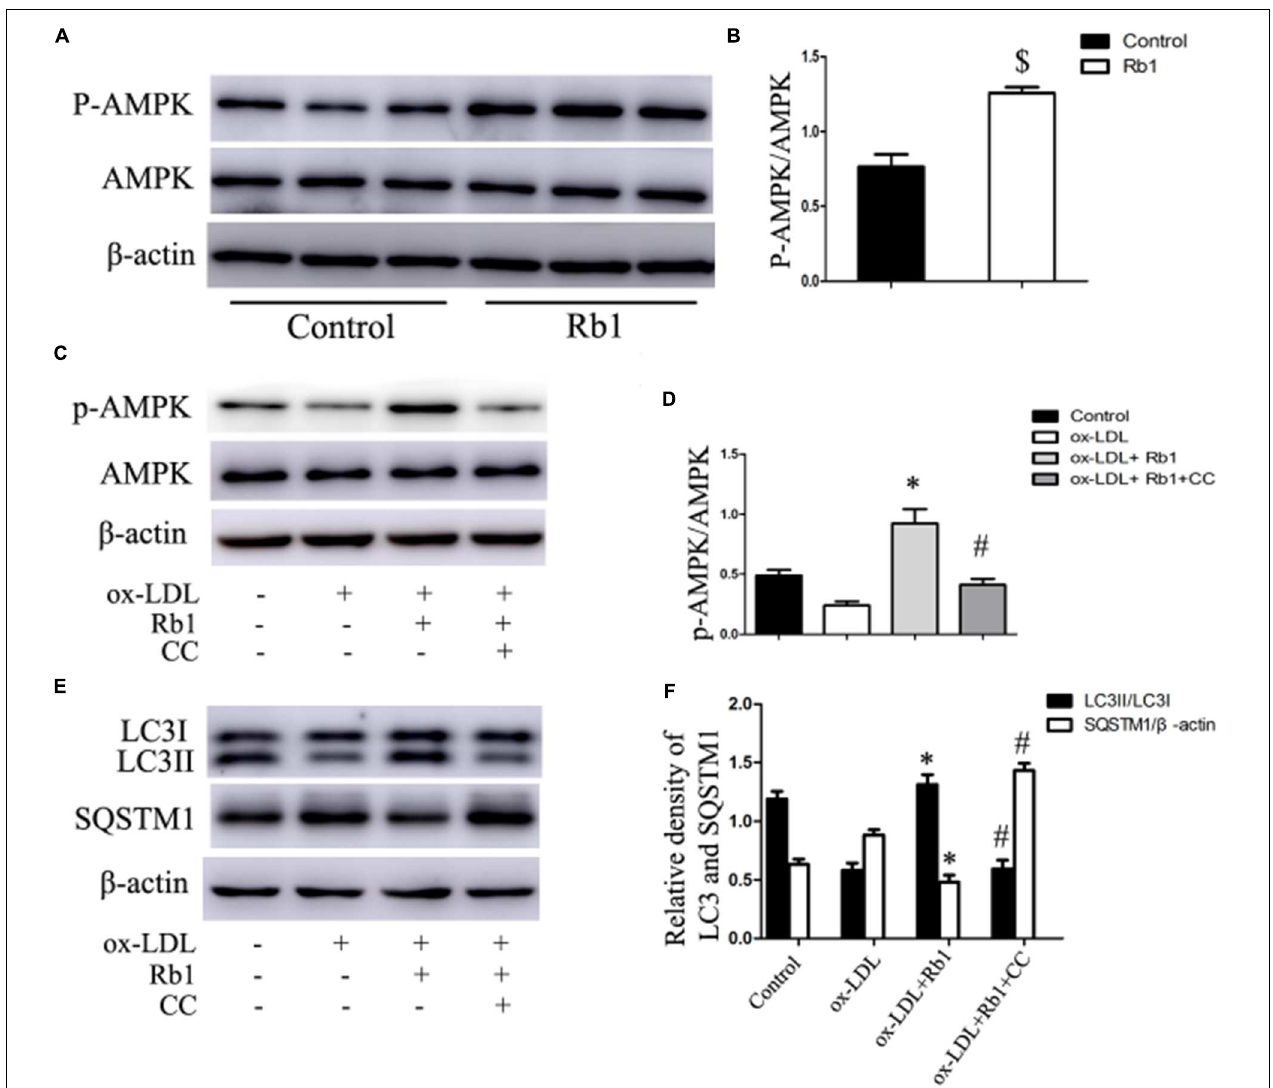
FIGURE 6 | Rb1 induced autophagy via promotion of AMPK phosphorylation. (A) Representative western blots and (B) quantification of p-AMPK/AMPK in atherosclerotic plaques of apoE - / - mice treated with Rb1 or saline (control). (C) Representative western blots and (D) quantification of p-AMPK/AMPK in macrophage foam cells treated with Rb1 in the presence or absence of 20 µ M compound C (CC). (E) Representative western blots and (F) quantification of LC3-II and SQSTM1/p62 in macrophage foam cells treated with Rb1 in the presence or absence of 20 µ M CC. ∗ p < 0.05, compared to the ox-LDL group; # p < 0.05, compared to the ox-LDL + Rb1 group; $ p < 0.05, compared to the control group, n =